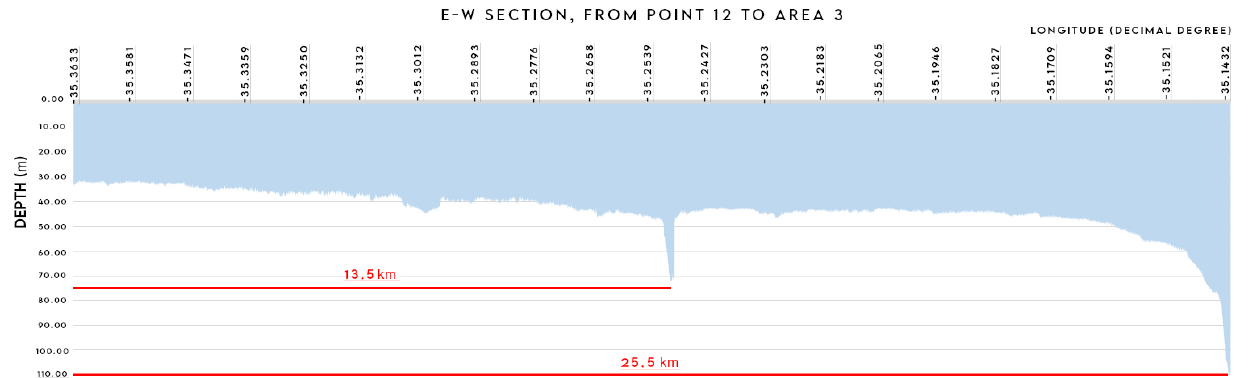
Figure 5. Longitudinal profile of the break of the continental shelf (area 3). Note the 55 × vertical exaggeration.